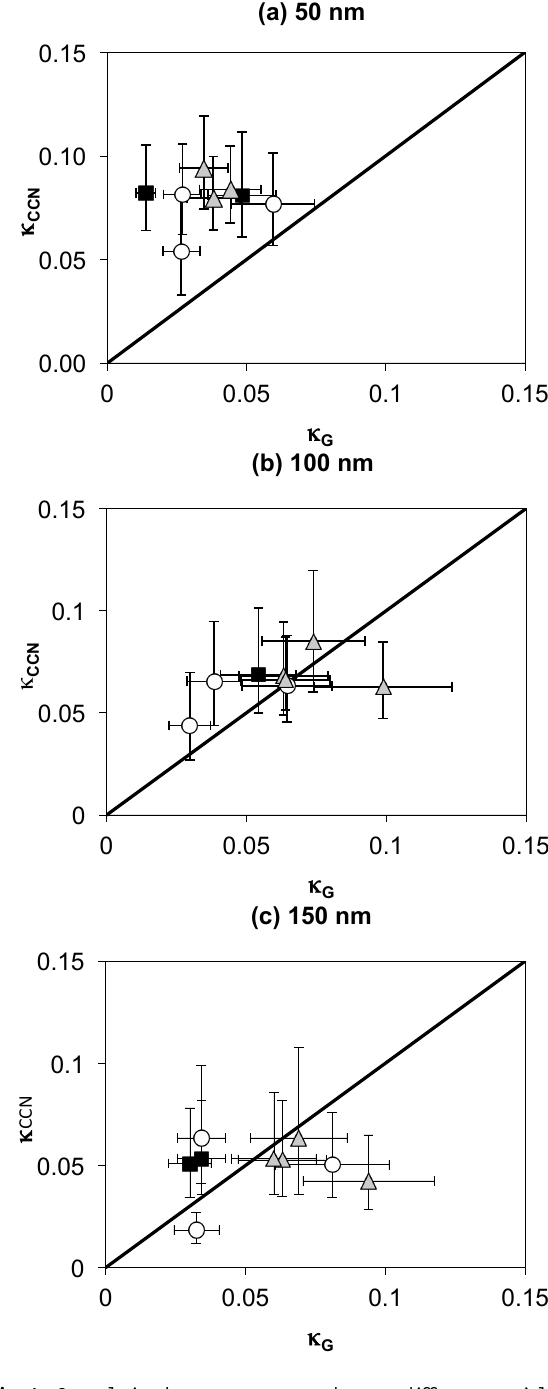
Fig. 4. Correlation between κ CCN and κ G at different particle di- ameters. Each data point represents an individual biomass burn- ing event of approximately 1h. Hardwood fuels (musasa, oak) are indicated as black squares, softwood fuels (spruce, pine) as white circles, and softwood fuels including needles and branches as gray